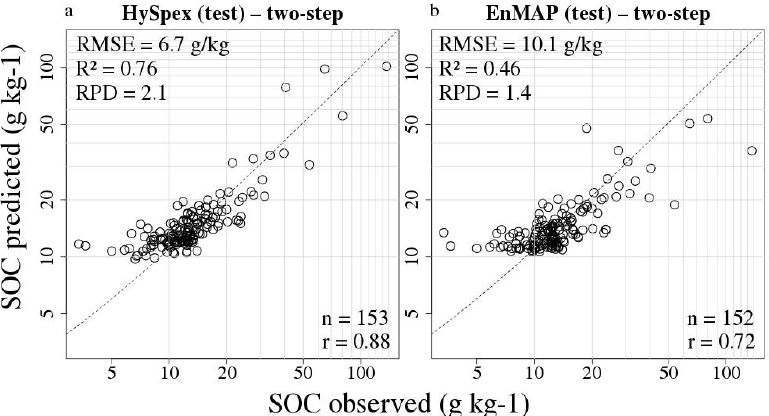
Figure 9. Observed vs. predicted SOC content on a logarithmic scale for the test set of soil samples used for SOC map assessment for the HySpex ( a ) and EnMAP sensors ( b ). n is the number of soil samples while r is Pearson’s correlation coefficient.